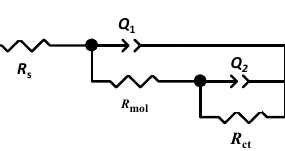
Figure 6. Equivalent electric circuits used in the system ( a ) without an inhibitor and ( b ) with inhib- itor.